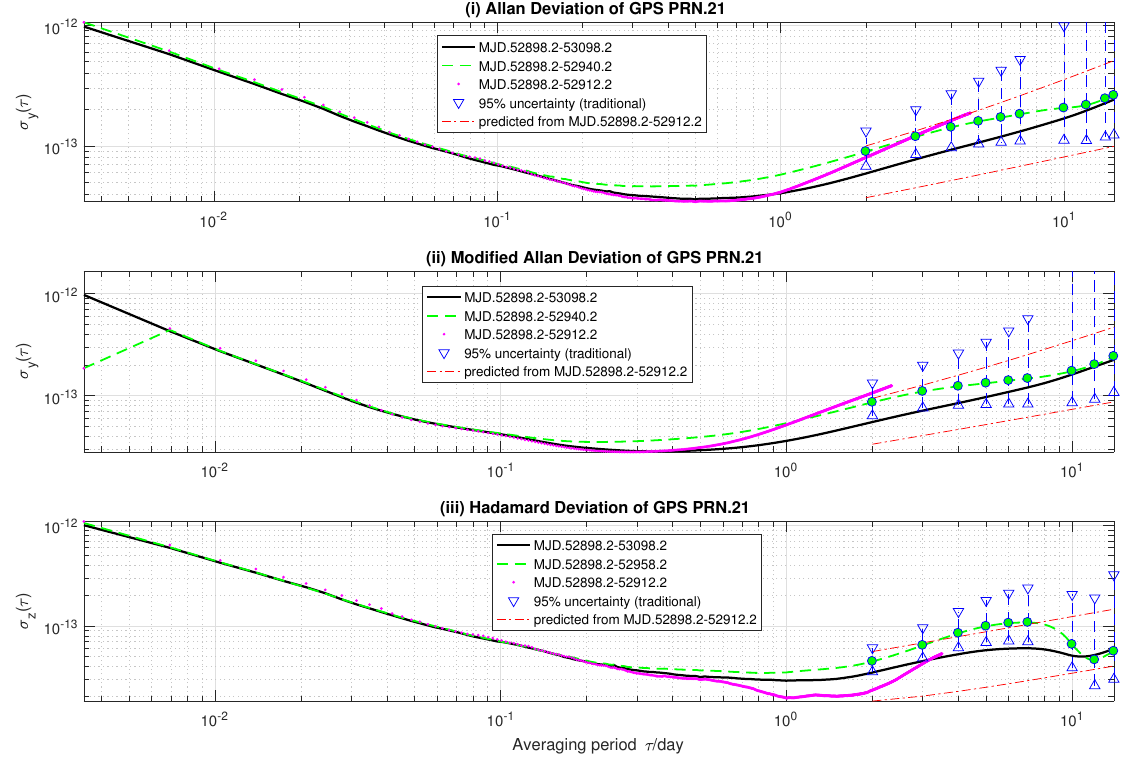
Figure 1. Estimates and prediction of GPS SVN.45 (PRN.21) rubidium clock frequency